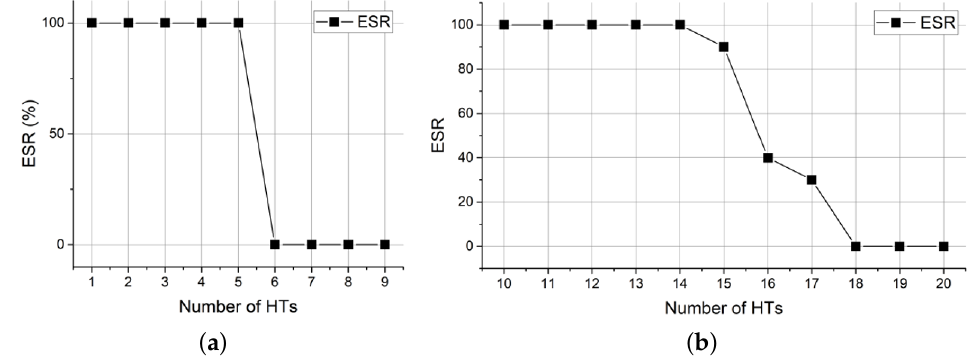
Figure 10. The ESR under different numbers of HTs. ( a ) circuit-I. ( b )